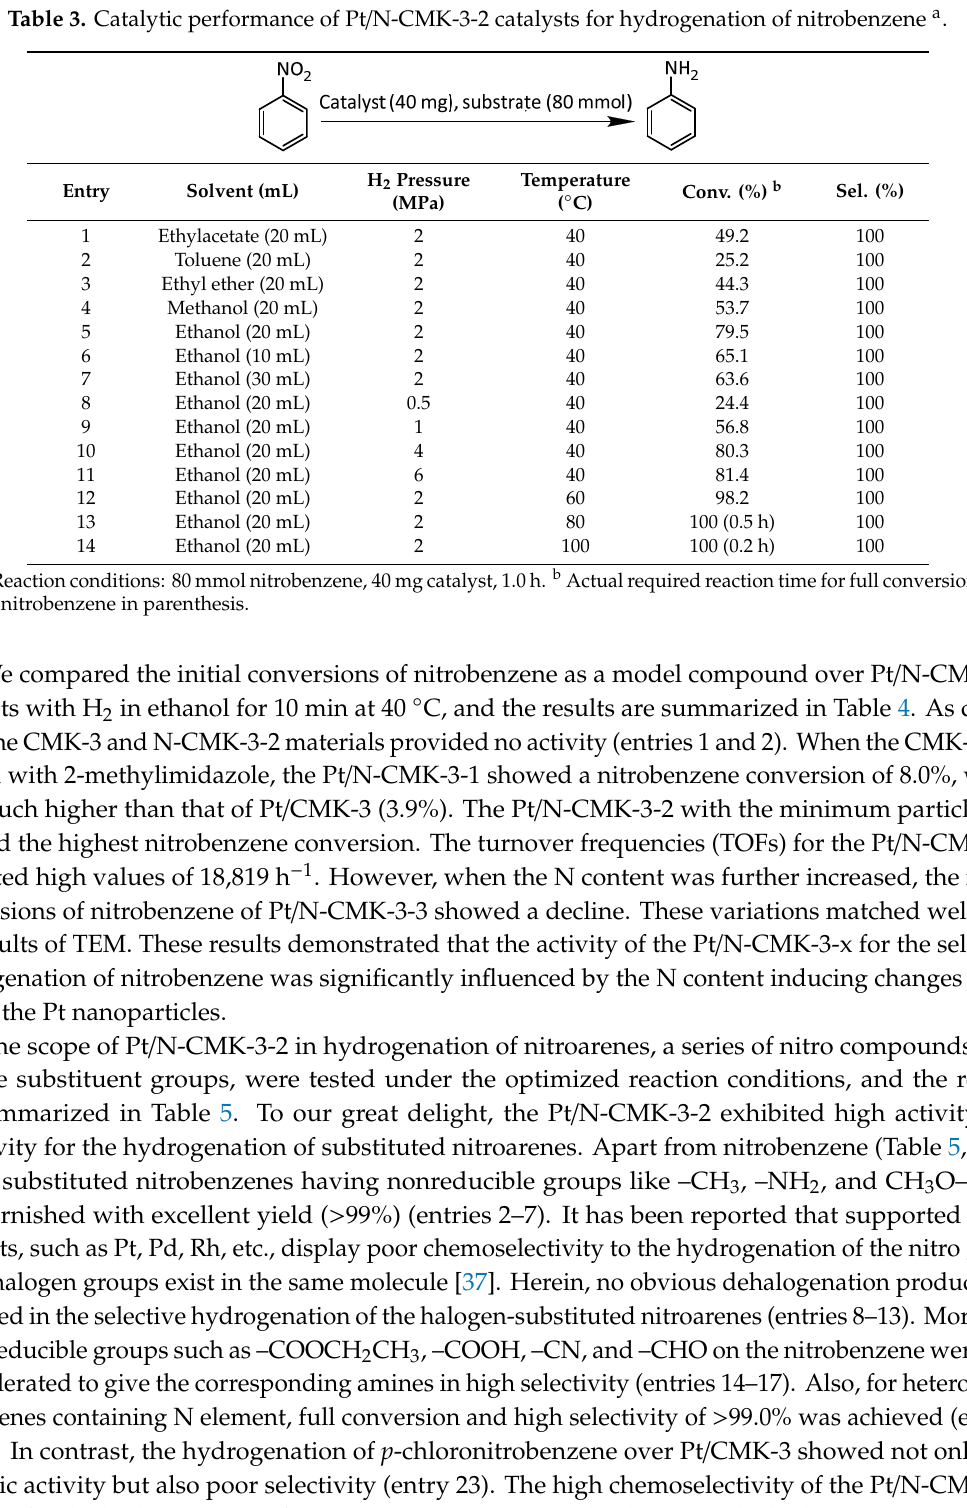
Table 3. Catalytic performance of Pt/N-CMK-3-2 catalysts for hydrogenation of nitrobenzene. a